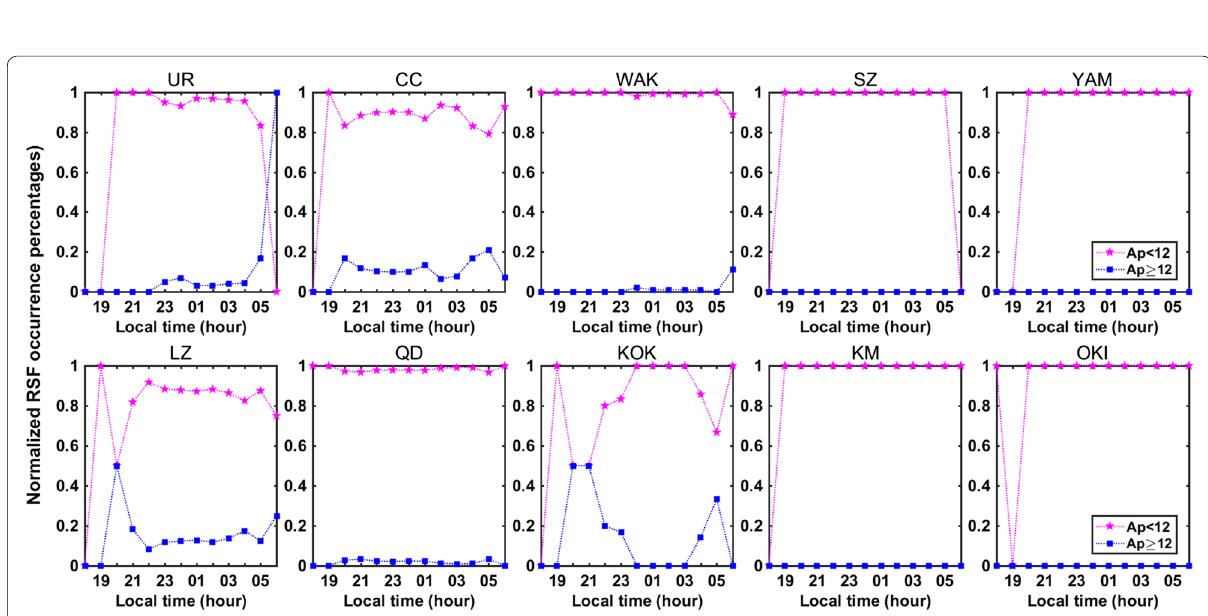
Fig. 9 Variations in normalized RSF occurrence percentages on different Ap index levels; magenta lines represent the low geomagnetic activity and blue lines represent the high geomagnetic